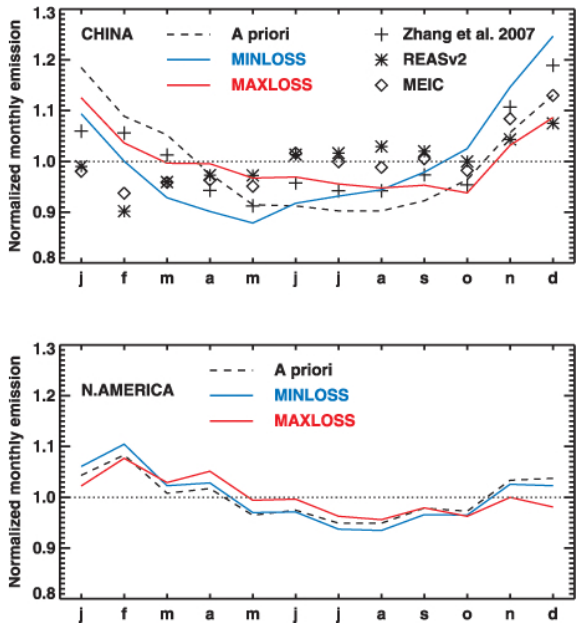
Fig. 8. Normalised seasonal variation of anthropogenic emissions over China (top) and North America